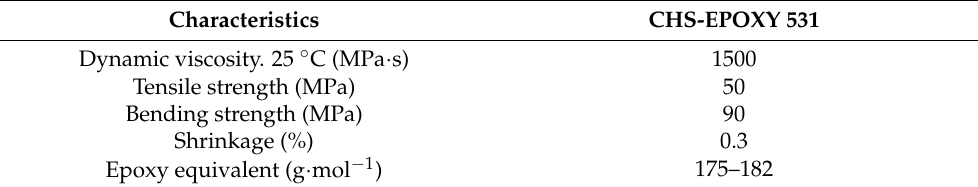
Table A1. CHS Epoxy 531